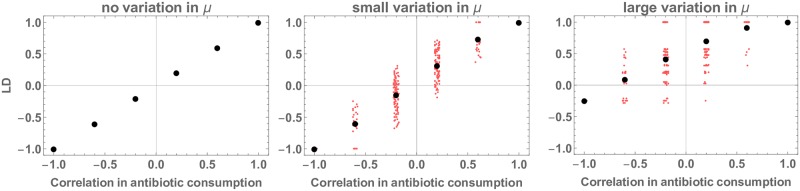
Linkage disequilibrium (measured as D′) between resistances in a two drug model with ten assortatively mixing host groups, as a function of the Spearman correlation between antibiotic consumption rates for the two antibiotics across the ten host groups.For each drug, five of these host groups consume antibiotics at a high rate (τhigh = 0.075 which selects for resistance when μ = 1) and five consume antibiotics at a low rate (τlow = 0.025 which selects for sensitivity when μ = 1). Consumption rates vary from perfectly anticorrelated (all host groups consuming the first antibiotic at high rate consume the second antibiotic at low rate) to perfectly correlated (all host groups consuming the first antibiotic at a high rate also consume the second antibiotic at a high rate). Left-hand panel: all host groups have the same clearance rate (μ = 1). Middle panel: small variation in clearance rate between host groups (0.5 ≤ μ ≤ 1.5). Each red marker corresponds to one possible configuration of antibiotic consumption and clearance rates (see Methods for details), the black markers represent the average of all possible configurations with the same correlation between antibiotic consumption rates (horizontal jitter is for visualisation purposes only). Right-hand panel: similar to middle panel but with larger variation in clearance rate between host groups (0.25 ≤ μ ≤ 2). Other parameters are β = 2, cβ = 0.95 for both antibiotics, cμ = 1 for both antibiotics.